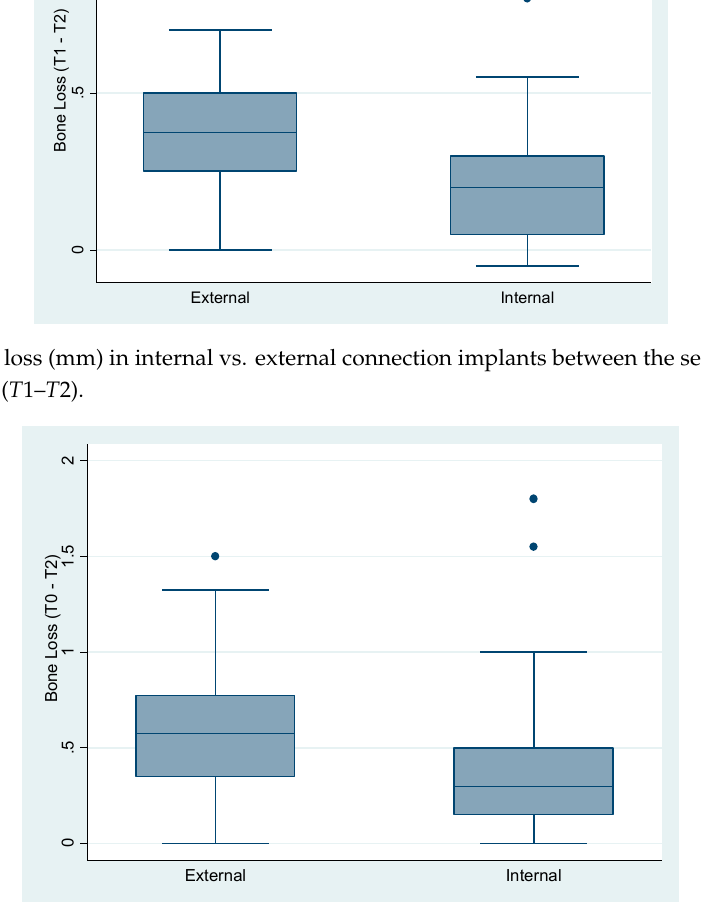
Figure 6. Bone loss (mm) in internal vs. external connection implants between the first and third measurements ( T 0– T 2).